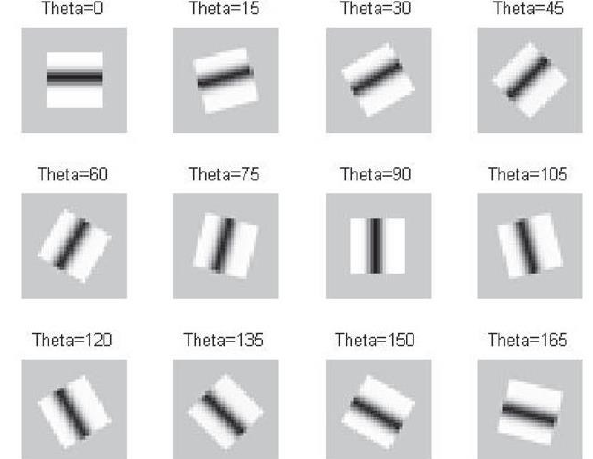
Figure 7. Illustration of the defined kernels (Adapted from Zhang et al.,